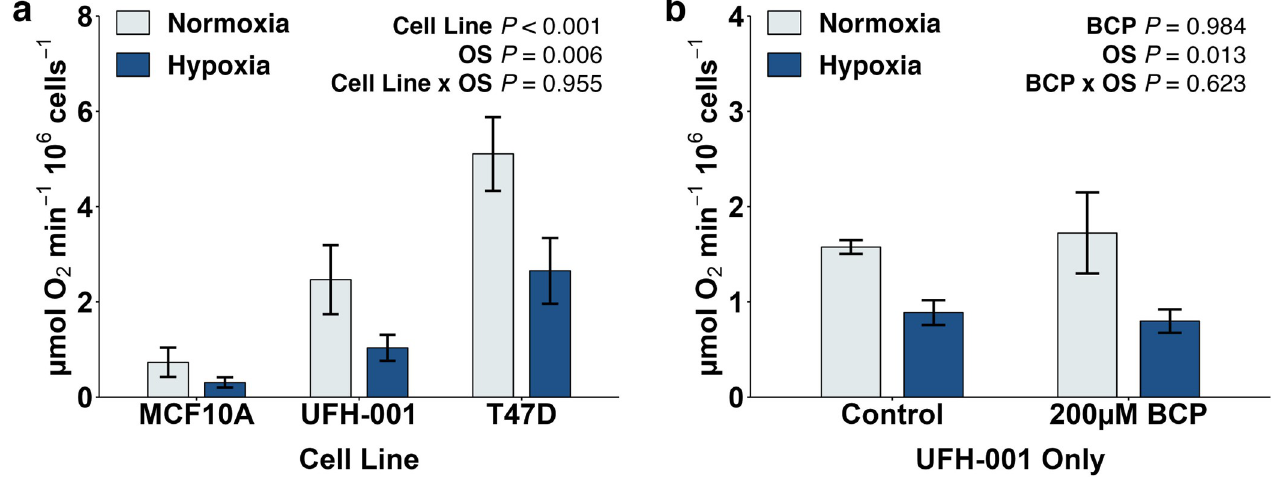
Fig 1. Oxygen consumption in breast cancer cells is sensitive to hypoxia but not BCP. (a) Cells were exposed to a normoxic environment or 1% oxygen in metabolic chambers. (b) In a separate experiment, UFH-001 cells were exposed to the same conditions but included 200 μ M BCP. At the end of 16h, cells were washed and resuspended in 2 mL PBS containing 25mM glucose, at 37˚C, and transferred to the oxygraphy to determine rates of oxygen consumption. Oxygen consumption is reported as μ mol/min/10 6 cells. Bars represent means ± S.E.M of 5 biological replicates in (a) and 3 biological replicates in (b). Data were analyzed by two-way